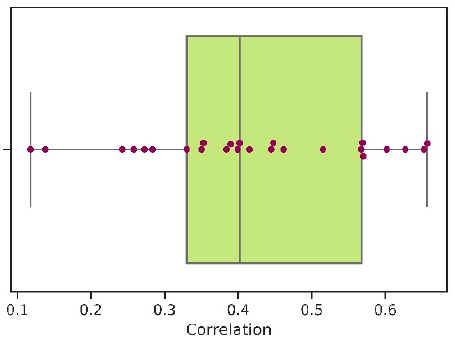
Figure 1. Spearman’s correlation coefficients between protein abundance and EEI for 25 prokaryotes.